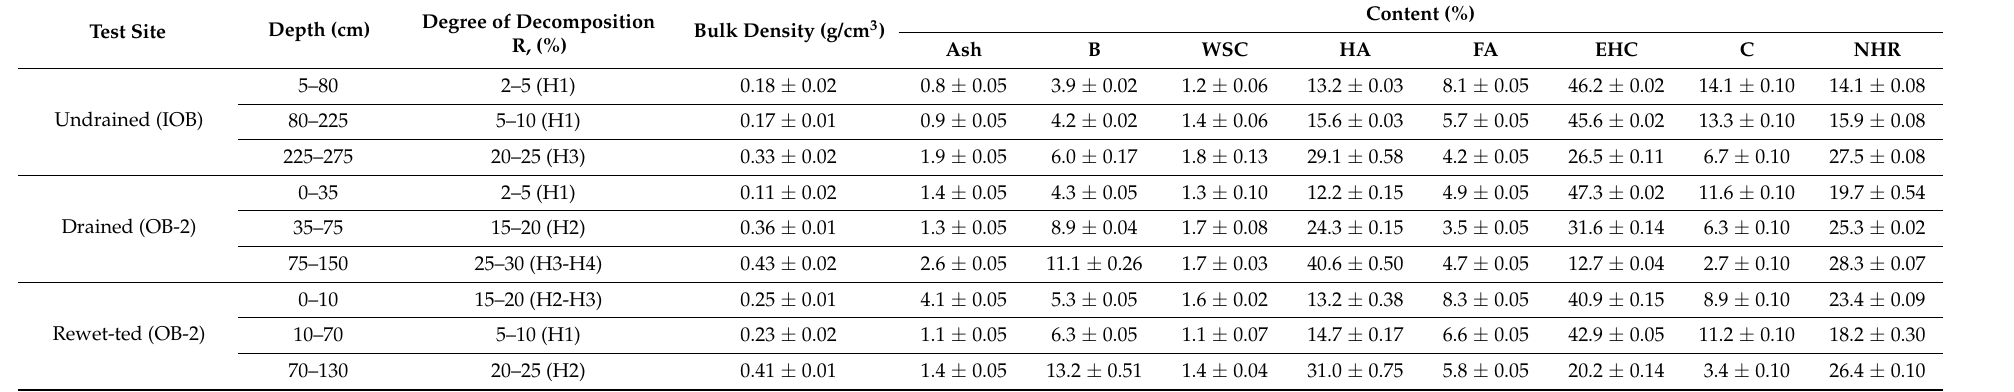
Table 2. Characteristics of peat deposits of the investigated study